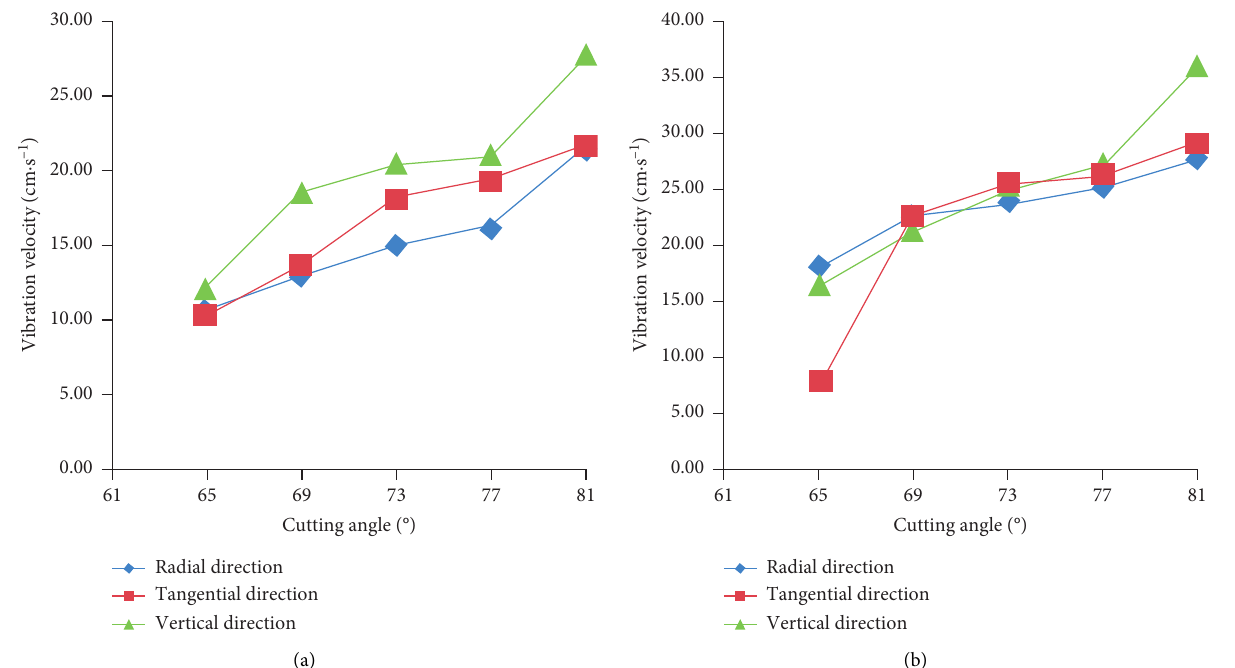
Figure 24: The curve of the (a) inclined and (b) vertical side maximum peak velocity with the change of cutting angle.